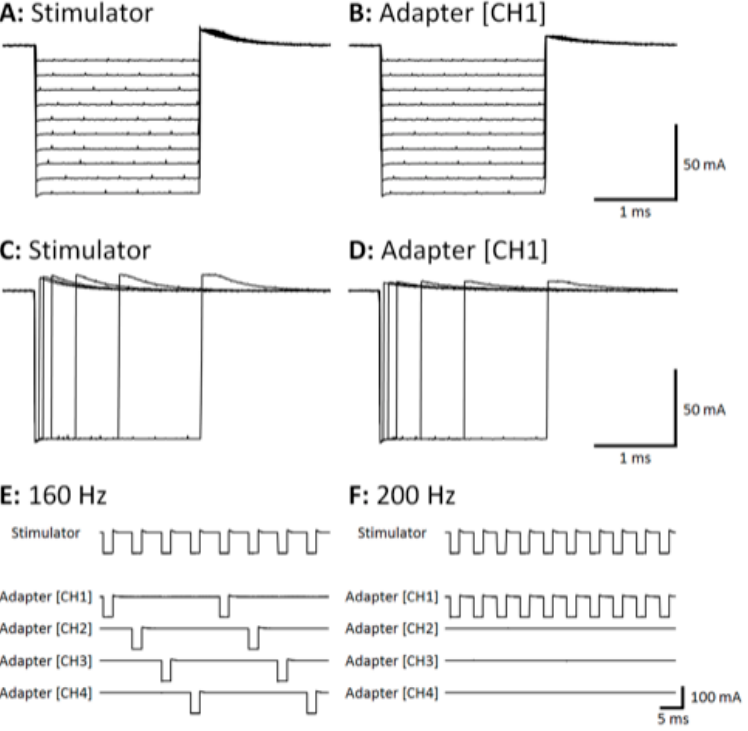
Figure 2. CH1, channel 1. Sample of pulses used to test the sequential stimulation (SEQ) adapter ( A , C ). Varying pulse amplitude with constant pulse duration ( A ), and varying pulse duration with constant pulse amplitude ( C ) are shown. Data were collected in separate trials but overlaid for visualization purposes. Sample of output pulse from a single channel of the SEQ adapter ( B , D ) corresponding to pulse settings in ( A , C ), respectively. Successfully rotated pulses from SEQ ( E ). Demonstrated failure at 200 Hz ( F